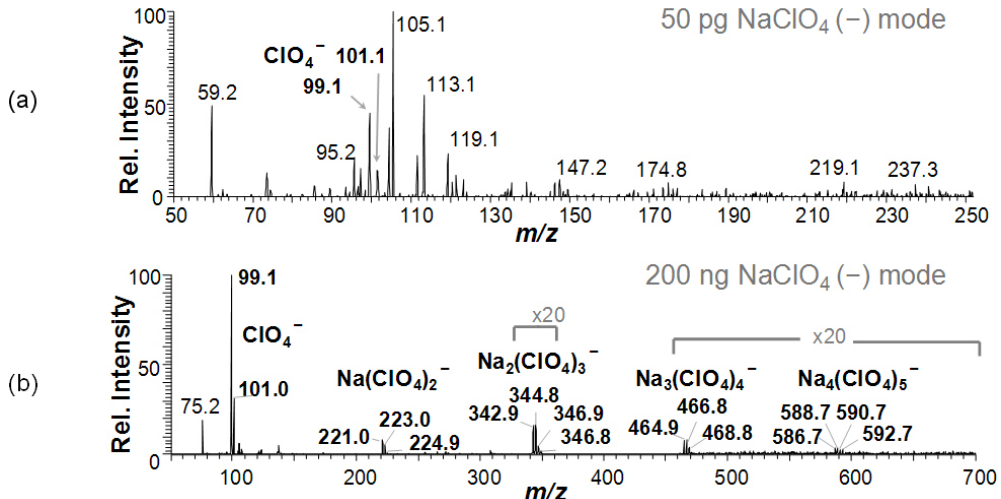
Figure 2. DESI mass spectra of (a) 50 pg sodium perchlorate deposited on porous PTFE surface, (b) 200 ng sodium perchlorate deposited on nonporous PTFE